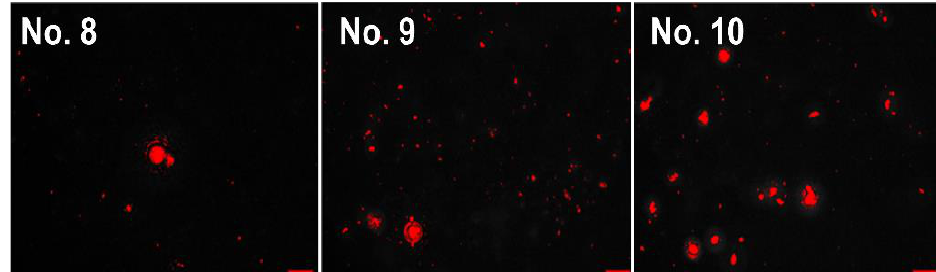
Figure 8. Images of the micro-organisms attached to specimens No. 8 – 10.